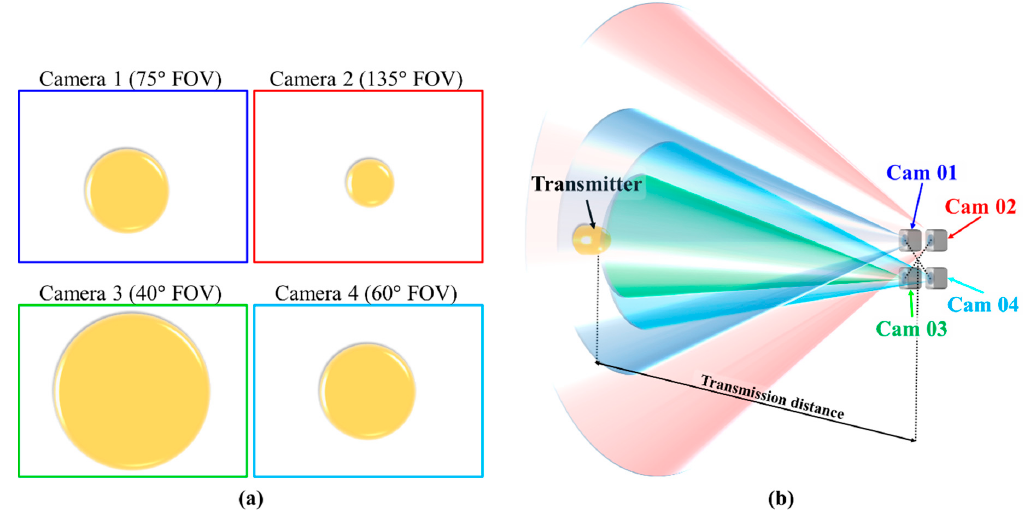
Figure 33. Multiple camera OCC enhancement: ( a ) perspective of each camera; ( b ) multiple camera concept.